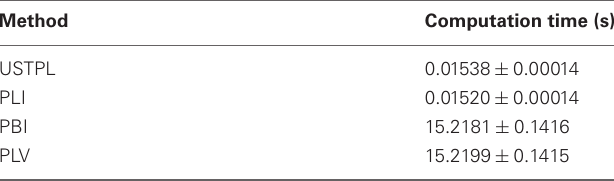
Table 1 | Time for computing a single significance statistic.